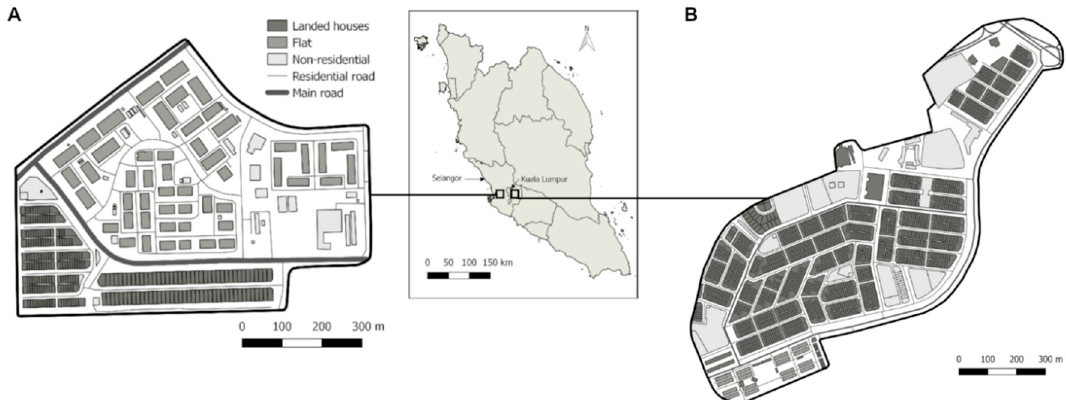
Figure 1. Map of collection sites of Aedes aegypti and Ae . albopictus , ( A ) PKNS, Shah Alam; ( B ) AU2, Keramat.